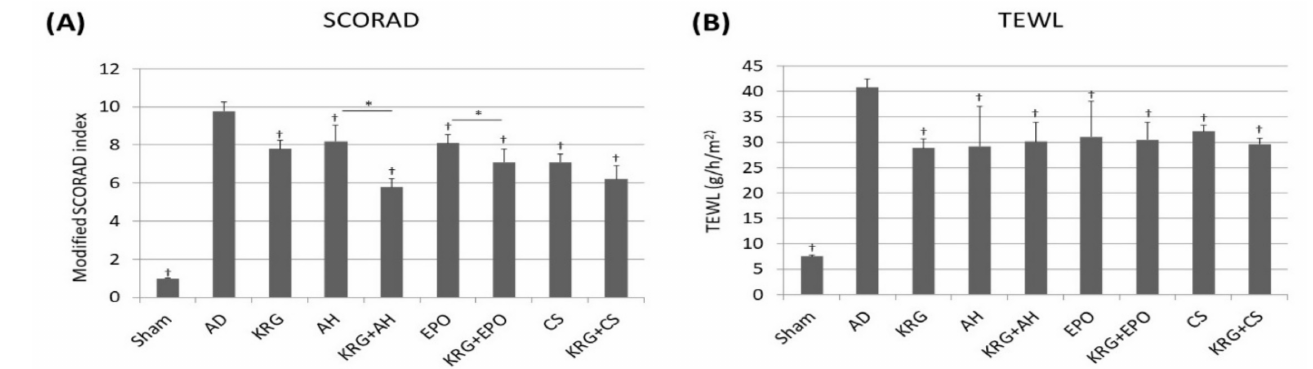
Figure 1. The clinical effects of KRG and the conventional systemic therapeutics of AD on the skin of NC/Nga mice ( A ) A modified SCORAD index for assessing the clinical severity of skin lesions in NC/Nga mice. ( B ) The changes in the epidermal barrier function were determined by measuring TEWL of the dorsal skin of the mice. † indicates p < 0.05 compared to the AD group. * indicates p < 0.05 in AH versus KRG + AH, CS versus KRG + CS, EPO versus KRG + EPO, respectively. All the data were presented as the mean and the standard error of the mean. Abbreviation: AD, atopic dermatitis; AH, antihistamine; CS, cyclosporine; EPO, evening primrose oil; KRG, Korean Red ginseng; SCORAD, scoring atopic dermatitis, TEWL, transepidermal water loss; TNCB, 2,4,6-trinitro-